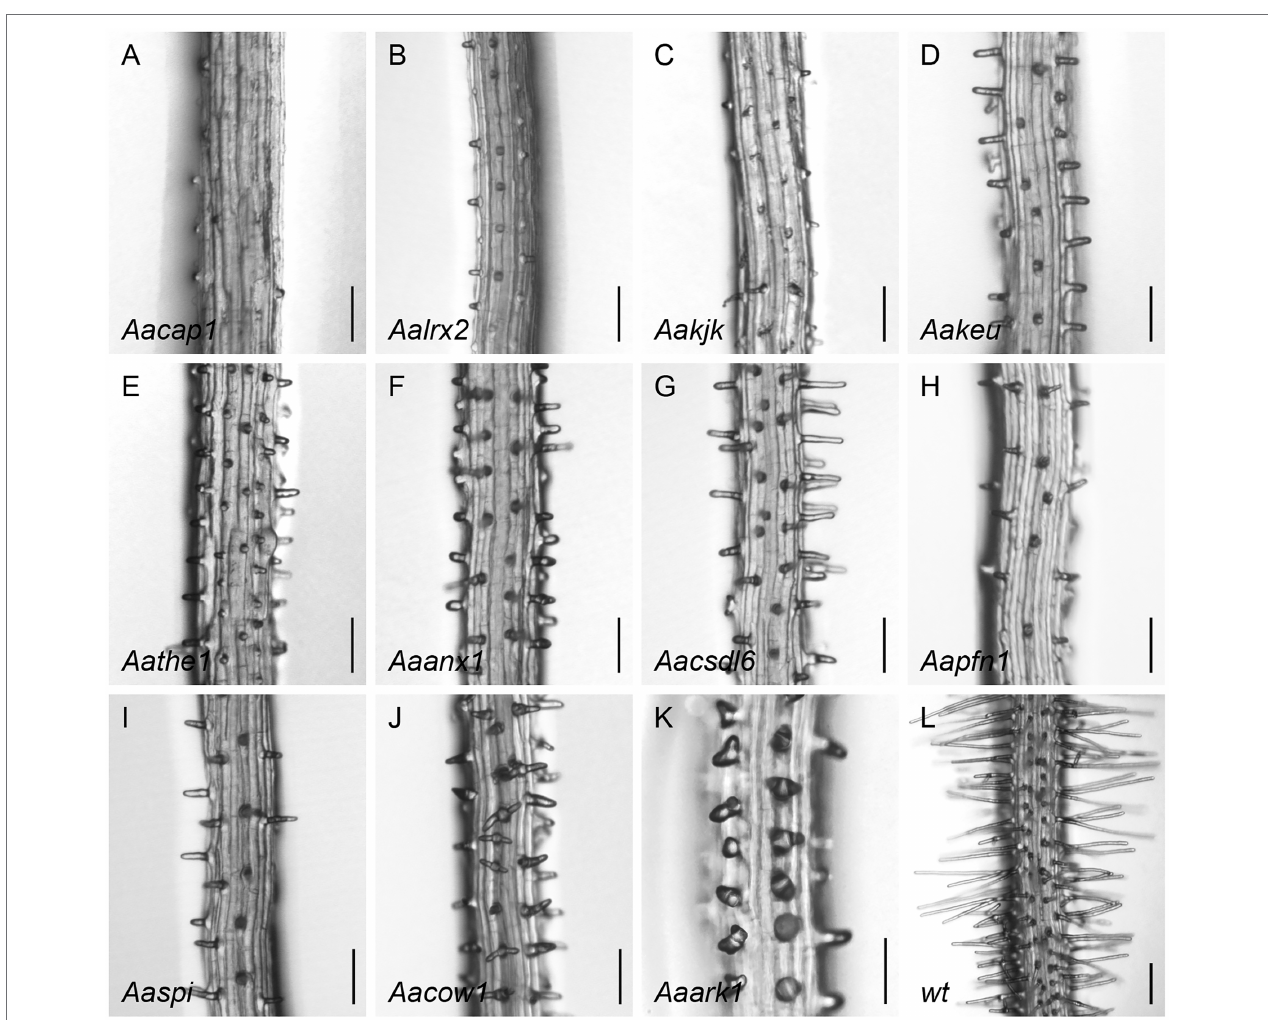
FIGURE 4 | Root hair phenotypes of identified A. alpina mutants in (A) [CA2+]CYT-ASSOCIATED PROTEIN KINASE 1 ( CAP1 ), (B) LEUCINE-RICH REPEAT/ EXTENSIN 2 ( LRX2 ), (C) KOJAK ( KJK ), (D) KEULE ( KEU ), (E) THESEUS 1 ( THE1 ), (F) ANXUR 1 ( ANX1 ), (G) CELLULOSE SYNTHASE-LIKE D6 ( CSLD6 ), (H) PROFILIN 1 ( PFN1 ), (I) SPIRRIG ( SPI ), (J) CAN OF WORMS1 ( COW1 ), (K) ARMADILLO REPEAT-CONTAINING KINESIN 1 ( ARK1 ), and of the (L) wild type. Scale bar: 250 μ